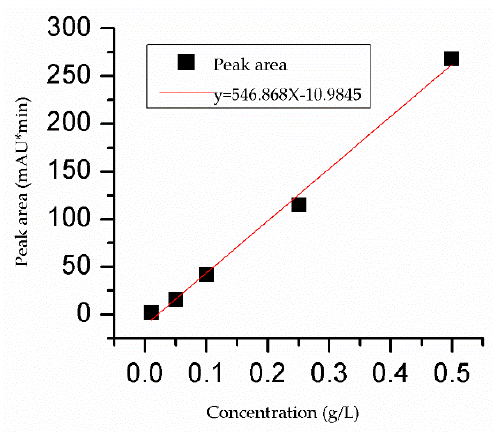
Figure 2. The standard curve of solanesol in methanol solution.